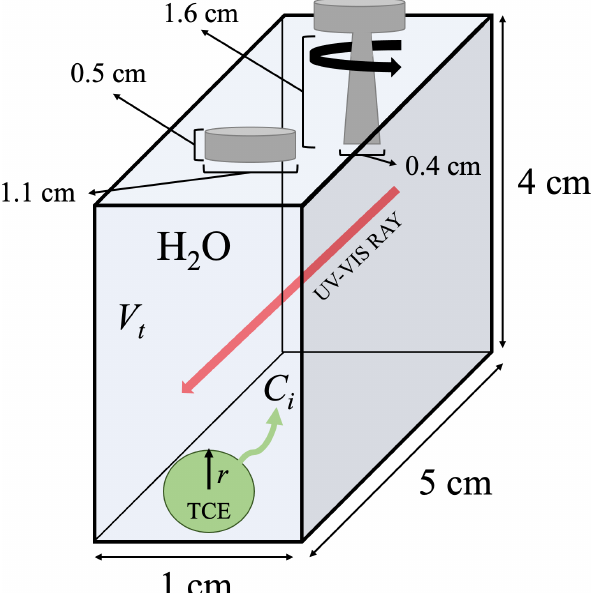
Figure 1. Experimental setup used for the mass transfer from a pool of TCE into an aqueous solution; r is the radius of a TCE drop (initial radius 0.5 mm), V t is the total volume of the aqueous phase (18 mL), and C i is the concentration of the TCE dissolved in the bulk phase; C i is spectrophotometrically monitored in time (sampling time 600